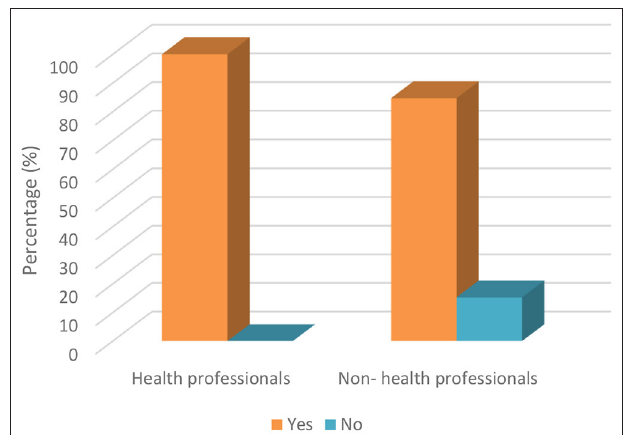
FIGURE 2 | Knowledge of parents’ about COVID-19 transmission by air droplets during dental treatment based on occupation.